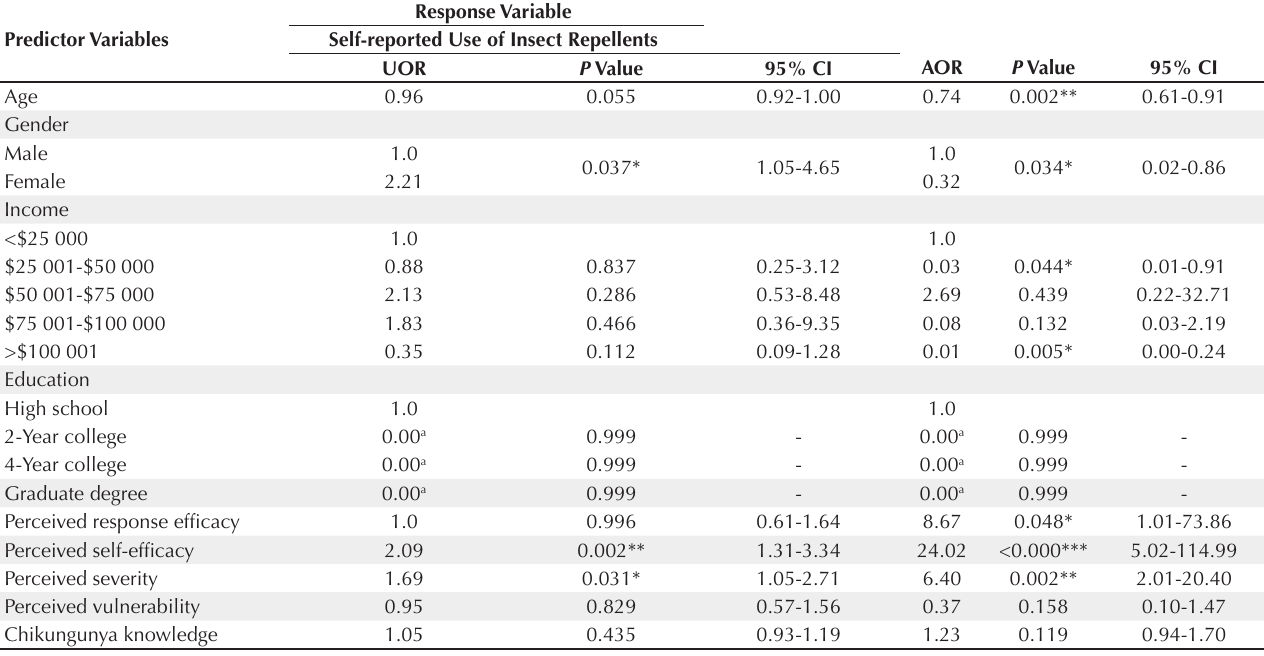
Table 3. Hierarchical Multiple Logistic Regression Analysis - Predictors of Self-reported Use of Insect Repellents